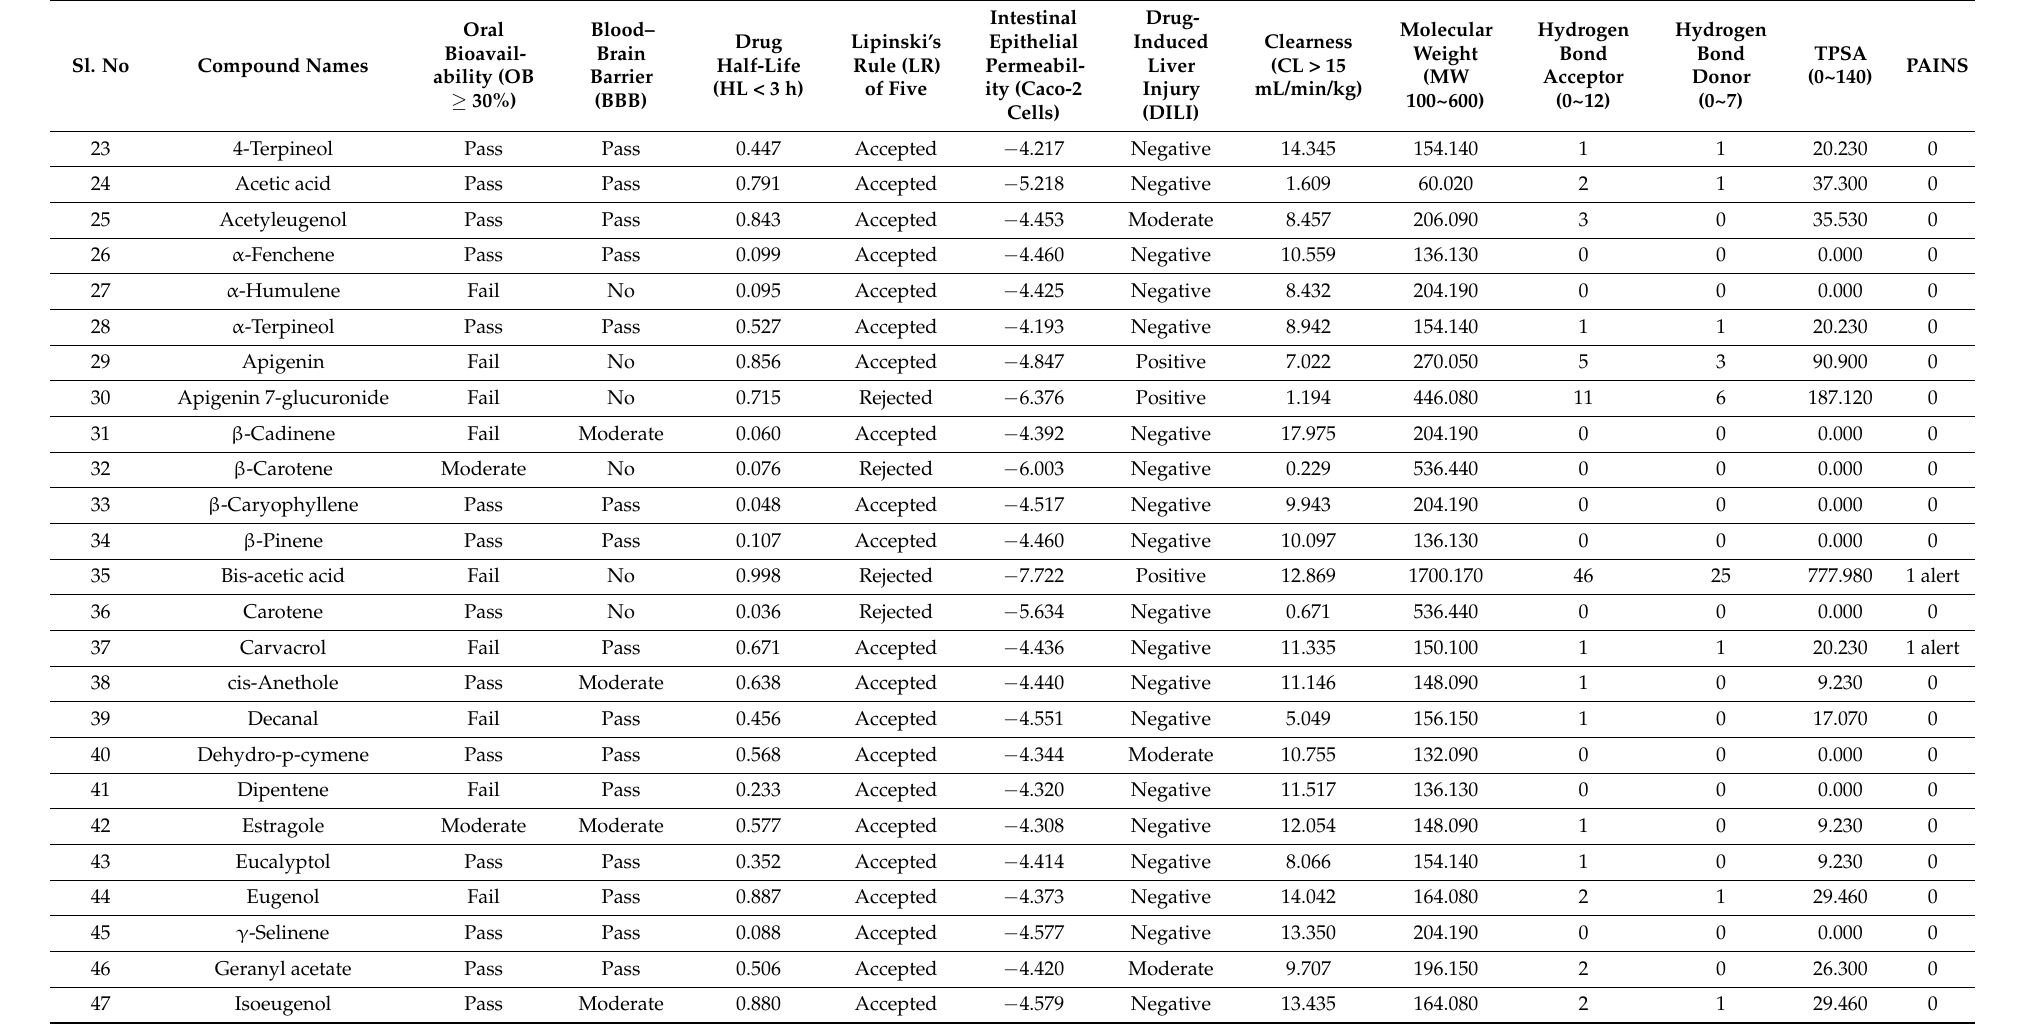
Table 2. Screening of active compounds using ADMET